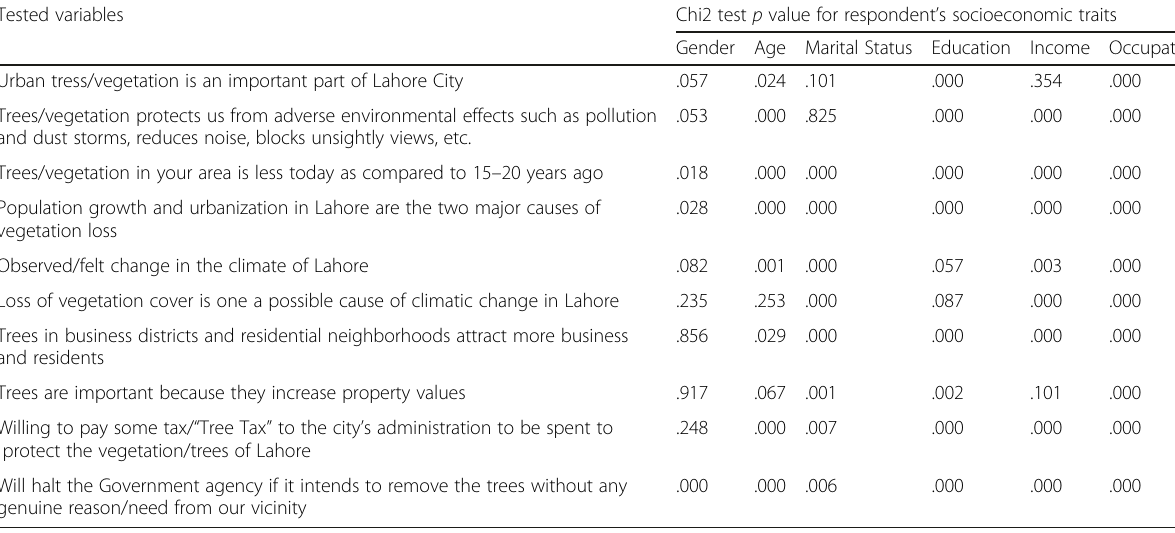
Table 6 Chi2 test results for respondent ’ s socioeconomic traits for 10 tested variables is some selected localities of Lahore, Pakistan Tested variables Chi2 test p value for respondent ’ s socioeconomic